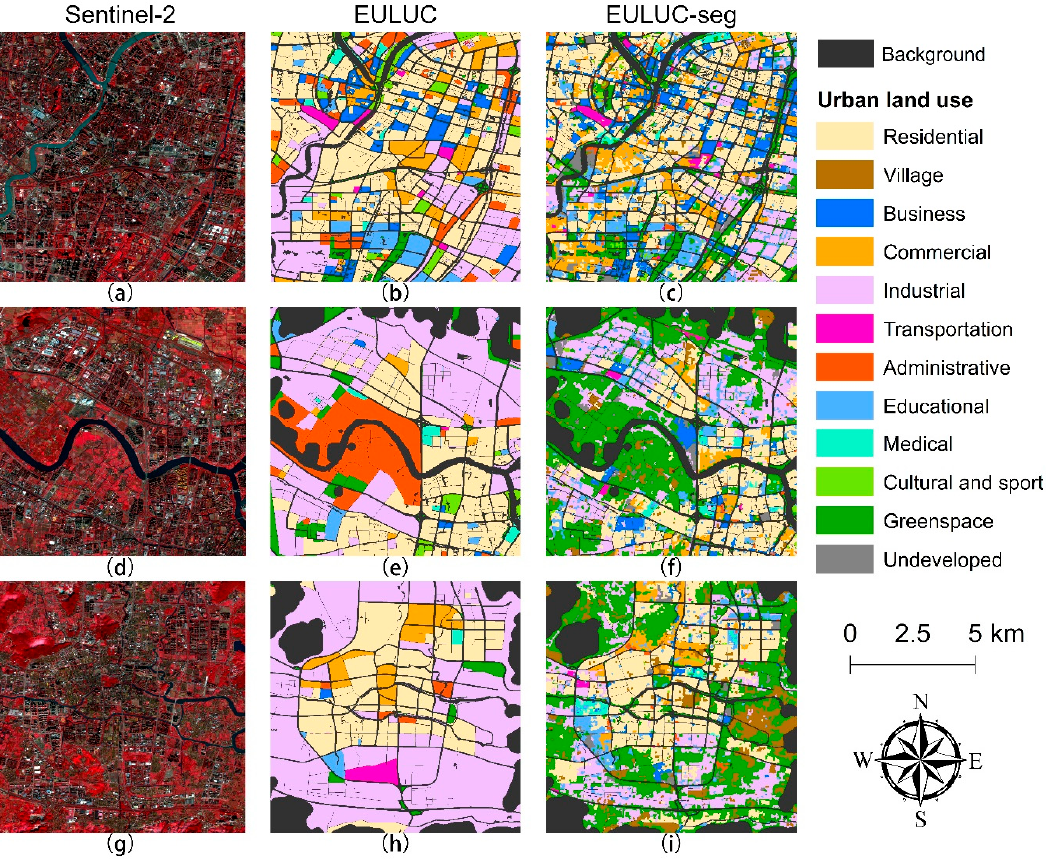
Figure 4. Comparison of remotely sensed images and urban land use mapping results. (a–c) The central urban area of Ningbo where three main rivers (Fenghua river, Yong river, and Yao river) run through. (d–f) A suburb located 10 km northwest of the central city. (g–i) The Yuyao county located 40 km west of the central city. Three columns from left to right denote the Sentinel-2 optical imagery (false color composition), maps of EULUC [1], and maps of EULUC-seg implemented in this study, respectively.